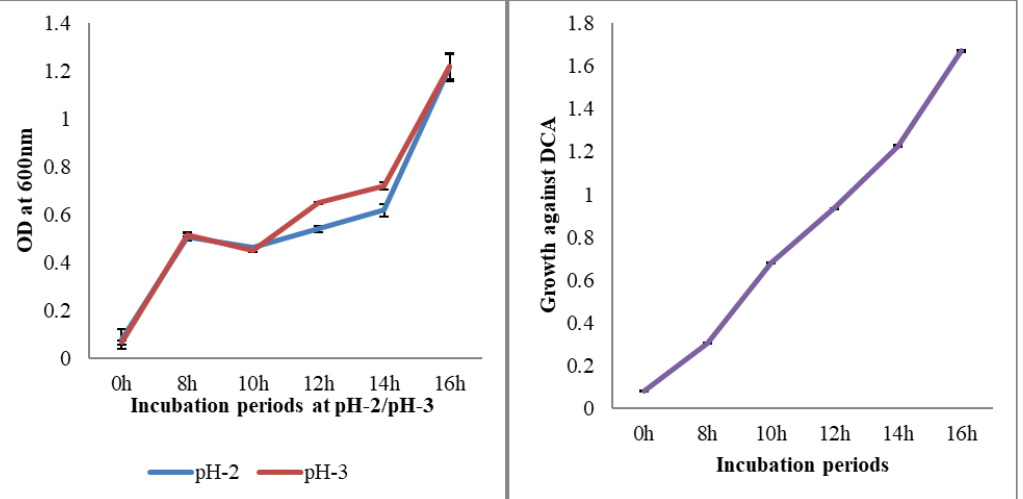
Figure 2. pH-resistant properties and survival ability at different pH and bile salt levels. Analysis was conducted in triplicate (n = 3).